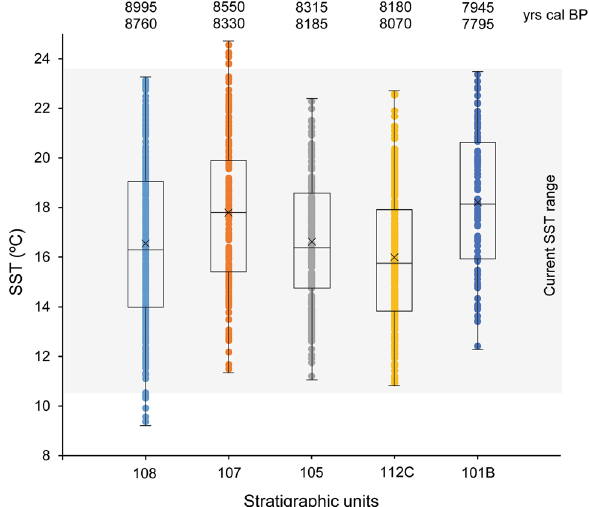
Figure 3. Estimated sea surface temperature (SST) derived from δ 18 O shell values obtained from P. lineatus shells recovered from the shell midden site of El Mazo cave (Asturias, N Spain). SST was calculated using Eqs. (1) and (2). Grey square shows current SST range in N Spain 31,32